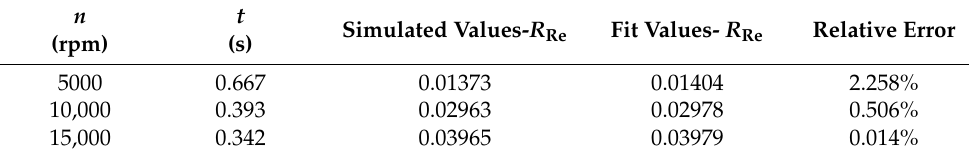
Table 2. Comparison between the simulated results and calculated values of Equation